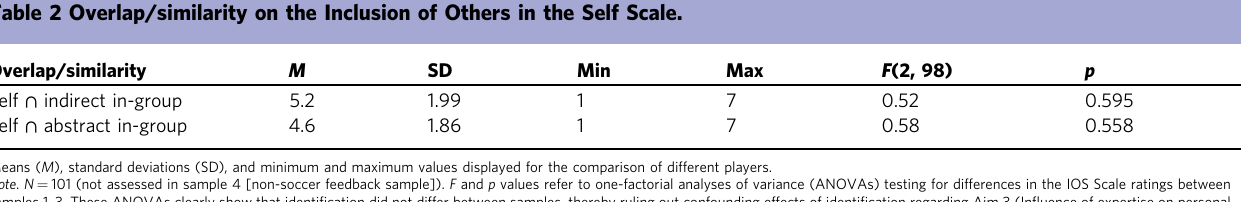
and social forms of optimism bias, see previous section) analyses.